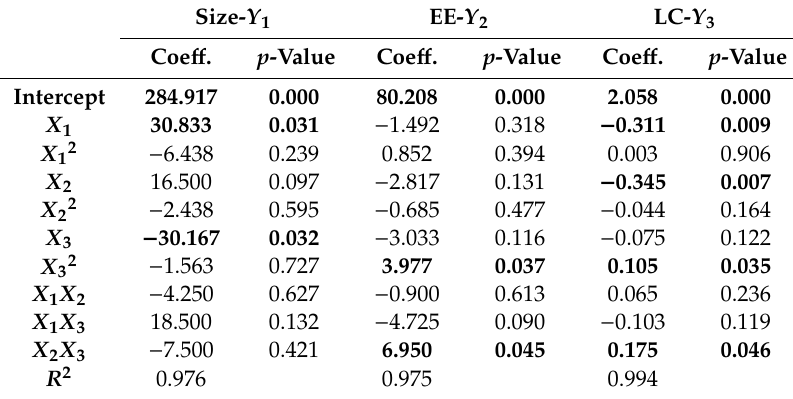
Table 3. Regression analysis for particle size ( Y 1 ), encapsulation e ffi ciency (EE) ( Y 2 ), and loading capacity (LC) ( Y 3 ) using the two-way interaction model (linear vs quadratic) based on the e ff ect of the amount of solid lipid ( X 1 ), liquid lipid ( X 2 ), and surfactant ( X 3 ). Size- Y 1 EE- Y 2 LC- Y 3 Coe ff . p -Value Coe ff . p -Value Coe ff . p -Value 284.917 0.000 0.000